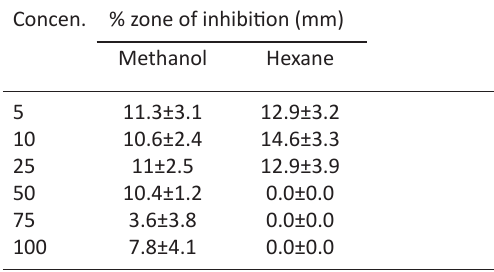
Table 5. Results obtained from the ANOVA analysis for methanol and hexane extracts for M. oleifera at 100%, 75%, 50%, 25%, 10% and 5% concentration against S. aureus ANOVA Source of Variation SS df MS F P-value F crit Between groups 118.8942 5 23.77883 4.815966 0.054747 5.050329 Within group 29.7675 1 29.7675 6.028861 0.057555 6.607891 Error 24.6875 5 4.9375 Total 173.3492 11 Table 6. Mean and Standard deviation for methanol and hexane extracts for C. cinereum at 100%, 75%, 50%, 25%, 10% and 5% concentration against P. aeruginosa Concen. % zone of inhibition (mm) Methanol Hexane 5 11.3±3.1 12.9±3.2 10 10.6±2.4 14.6±3.3 12.9±3.9 10.4±1.2 0.0±0.0 0.0±0.0